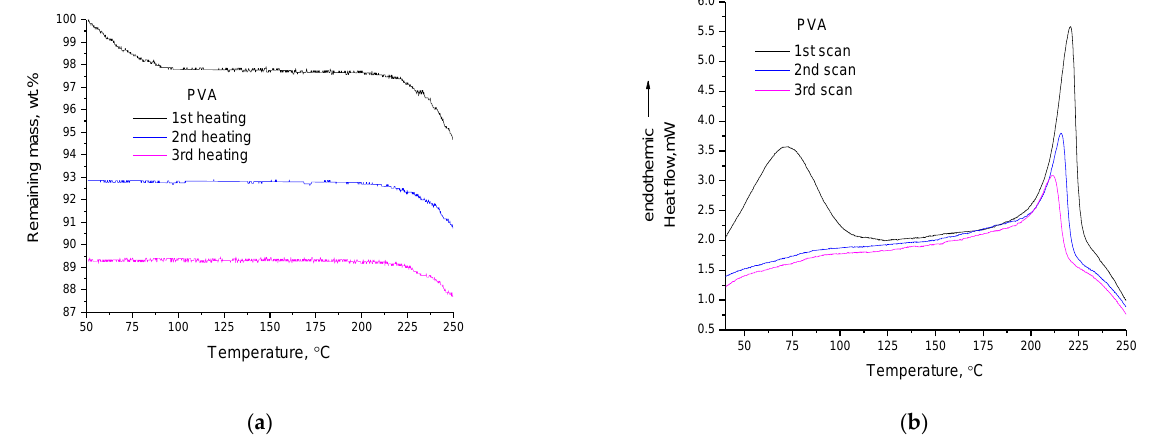
Figure 1. ( a ) Three consecutive TGA heating cycles of PVA; ( b ) Three consecutive DSC scans of PVA. In the previous study regarding PVA [12], the heat of decomposition was examined along with the mass loss, but there was no discussion about the alterations of the heat capacity during thermochemical transition. In general, the DSC signal ( s ) is influenced by the heat absorbed by the sample (apparent heat capacity). This heat equals to the heat capacity ( c ) of the sample that is, mass ( m ) times specific heat capacity ( C p ) plus any heat ( Q ) that may be absorbed or released during heating, e.g., heat for vaporization of impu- rities, heat for melting, decomposition, etc. That is , s = c + Q = m × C p + Q . From the DSC curves it is obvious that, independently of the number of heating cy- cles, besides the overall asymmetry of the peak, the DSC signal of PVA is decreased after the thermochemical transition (end of the peak) compared to the respective value at the beginning of the transition (also see Introduction and Figure S1 in Supporting Infor- mation). In addition, the DSC signal after the endothermic peak is constantly decreasing (shifting towards exothermic direction). This clearly points out that the heat absorbed by the sample (DSC signal, s) is constantly decreasing. The following four factors can poten- tially contribute to this decrease: